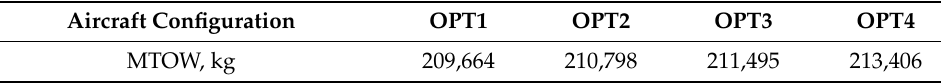
Table 3. MTOWs of four HWB